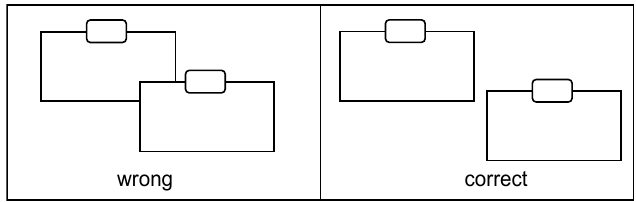
Figure 4.1: Nodes must not overlap.